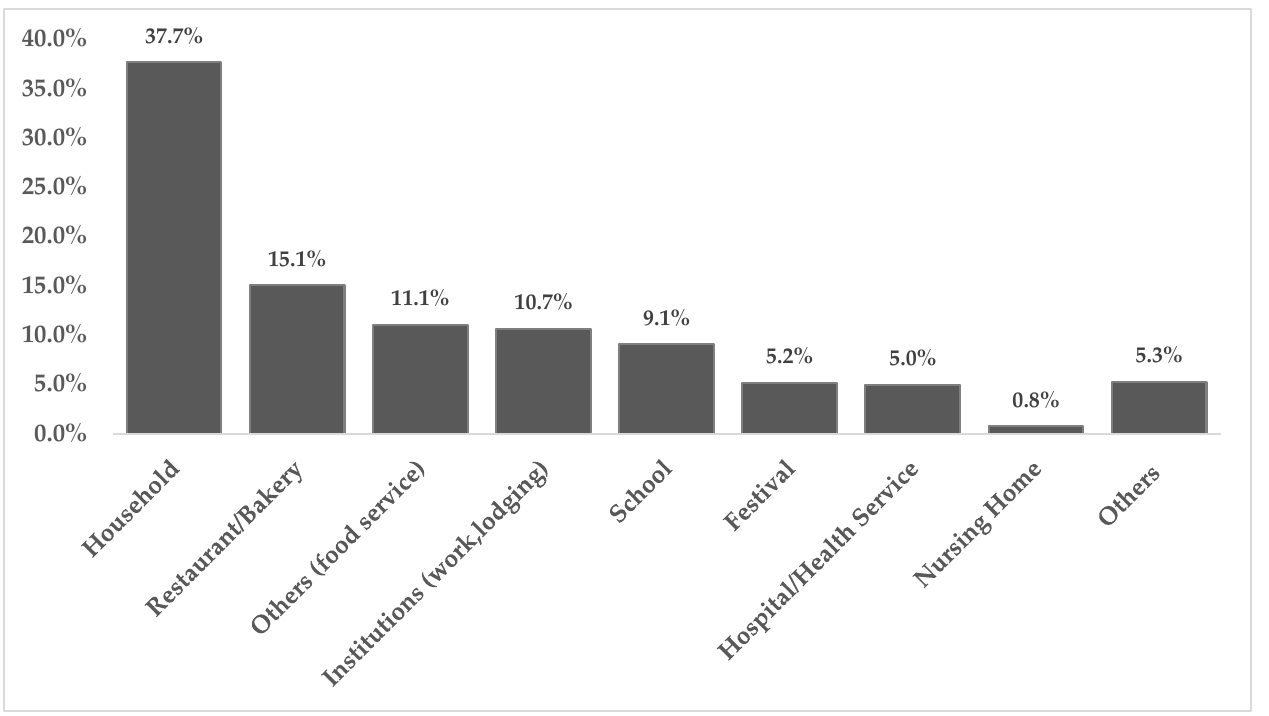
Figure 2. Percentage of FBD outbreaks by place of occurrence in Brazil between 2012 and 2021 Source: Adapted from [8].